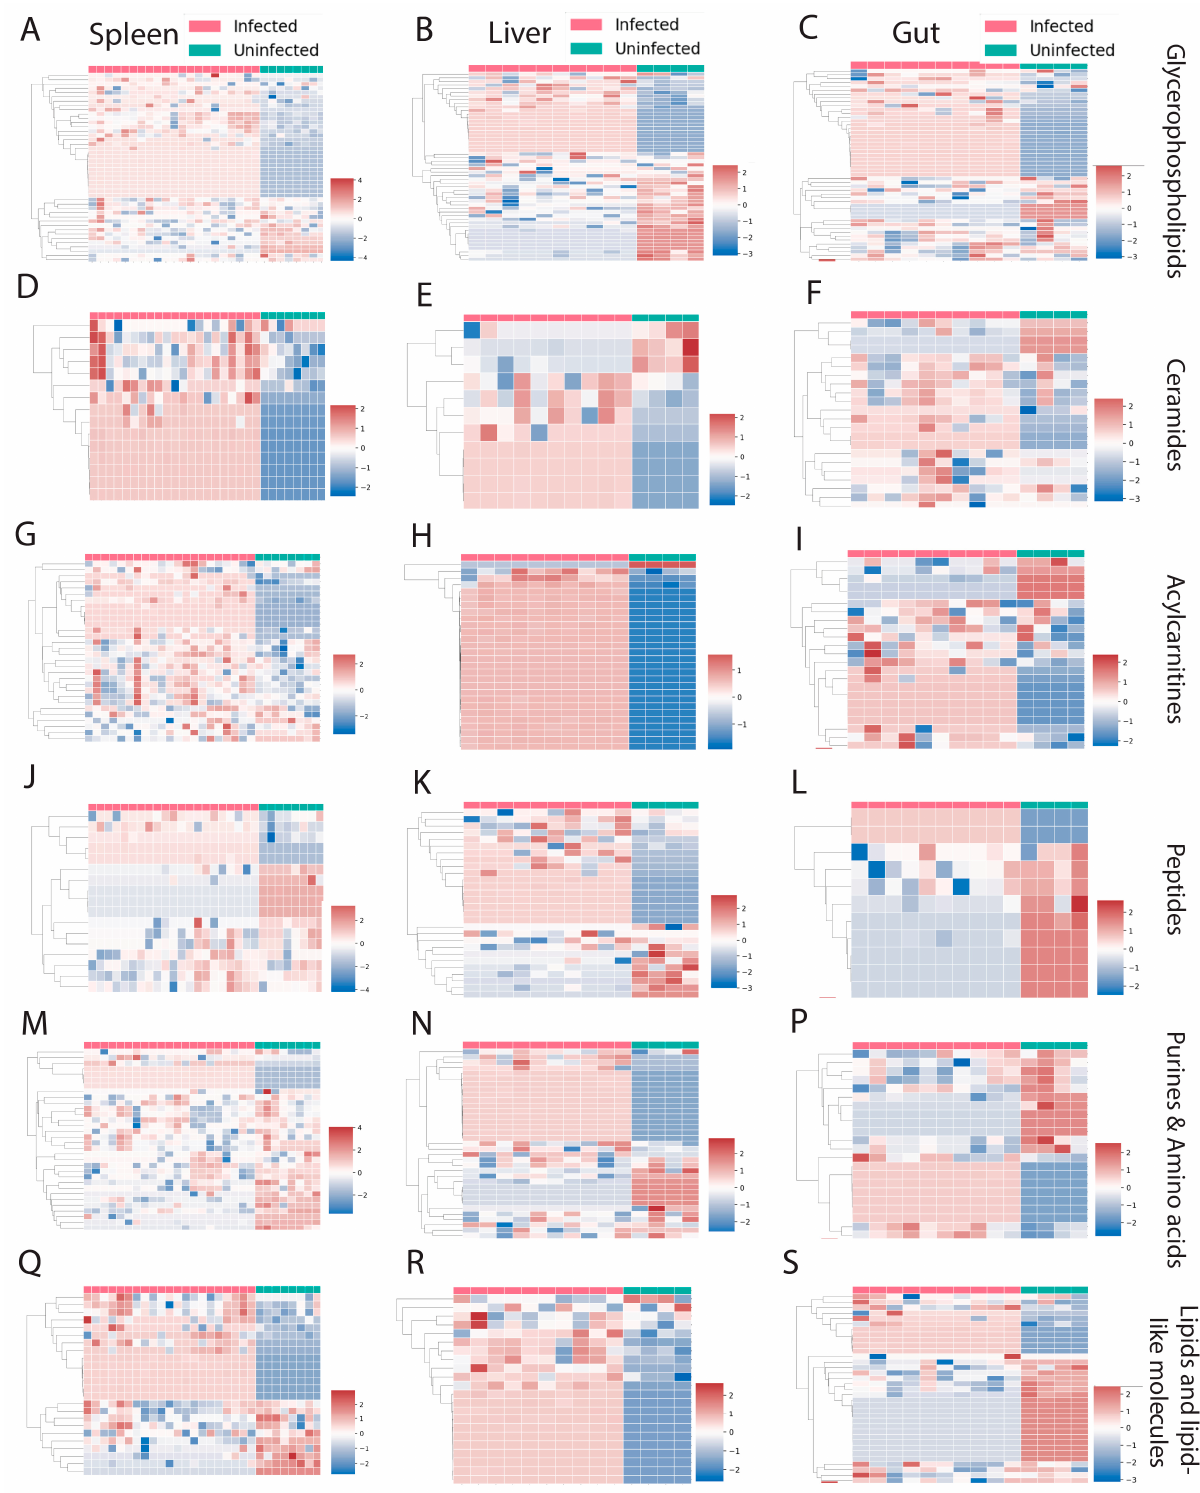
Figure 2. Perturbed chemical families that are in common between three organs in both negative and positive mode. ( A – C ) Glycerophospholipids. ( D – F ) Ceramides. ( G – I ) Acylcarnitines. ( J – L ) Peptides. ( M – P ) Purines and amino acids. ( Q – S ) Lipid and lipid-like molecules. Infected samples are shown in red and uninfected samples in green. Each column represents one sample, and each row represents one metabolite feature. Scale shows zero mean and unit variance (higher than zero mean = red and lower than zero mean = blue color) for each row.